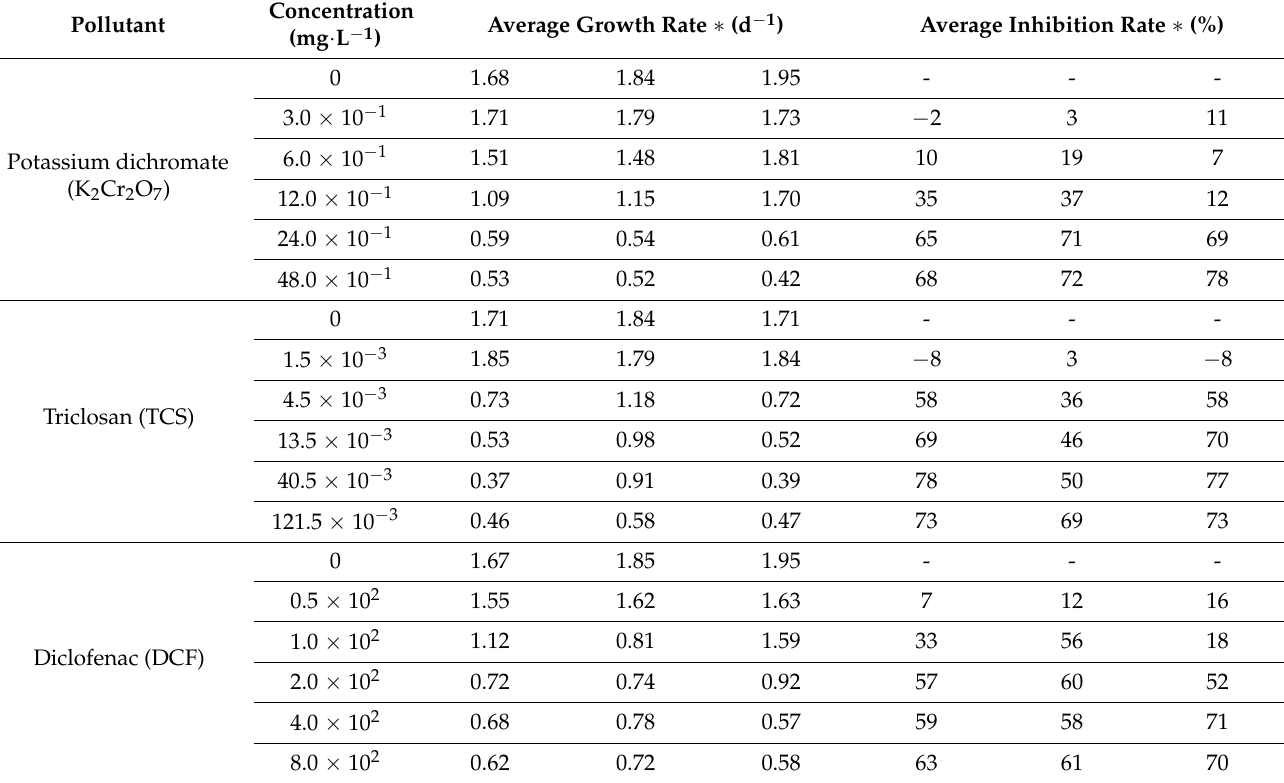
Table 2. Results of tests with the living (free) culture of R. subcapitata